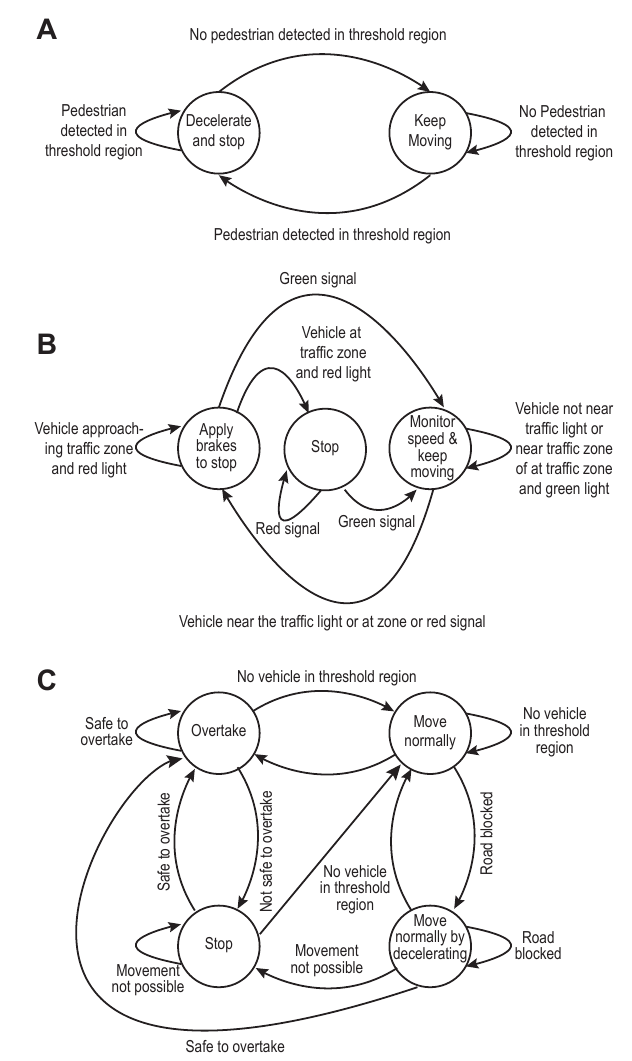
Figure 6. Transition diagrams for handling different traffic situations. The transition diagram for: handling pedestrians is shown in ( A ), vehicles approaching a traffic light is shown in ( B ) (yellow and red lights are treated as the same colour), and normal road condition and overtaking is shown in ( C